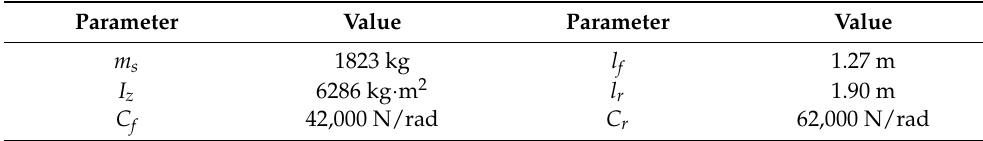
Table 1. Parameter of F-segment sedan in